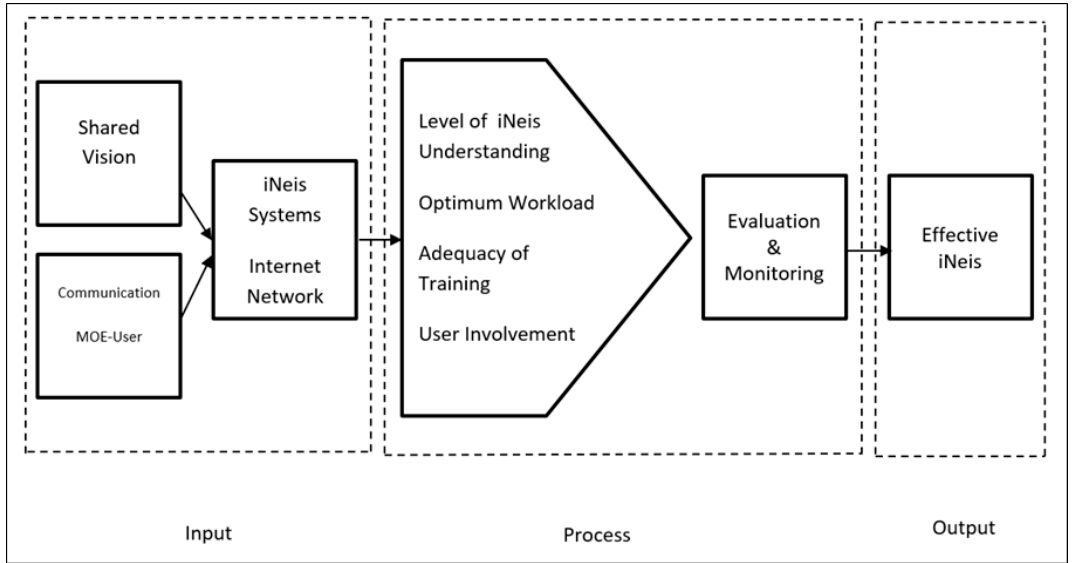
Figure 3. E-iNEIS TM framework.